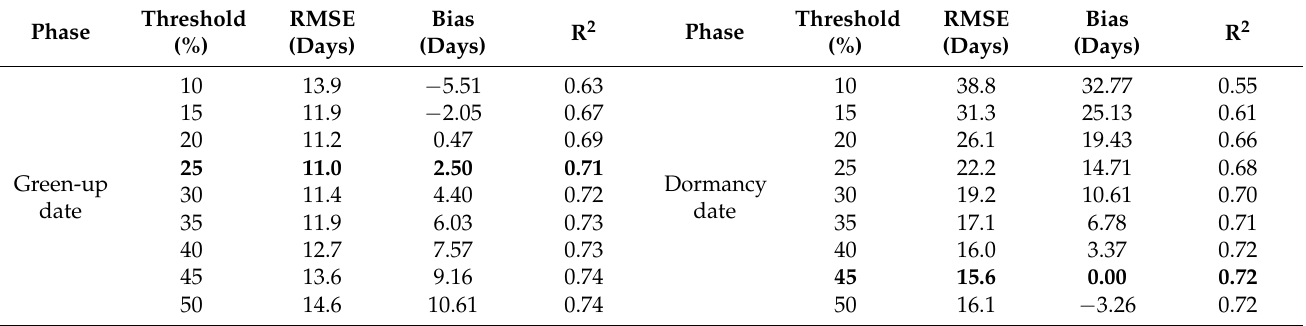
Table 1. Statistical summaries for comparison between near-surface phenology and SGLI phenology using different thresholds for green-up date and dormancy date. The selected thresholds are shown in